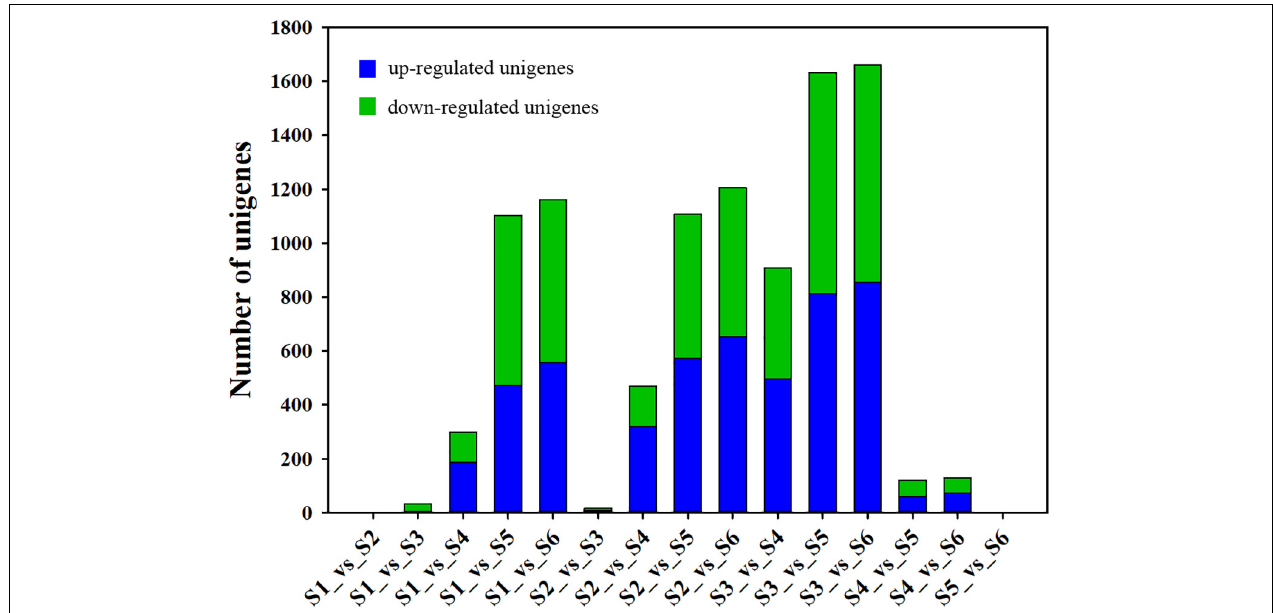
FIGURE 3 | Identification of differential expressed unigenes by pairwise comparisons. “S1_vs_S2” represents “the comparison between S1 and S2” or “S1 compared to S2”. The same applies to all other comparisons between S1 and